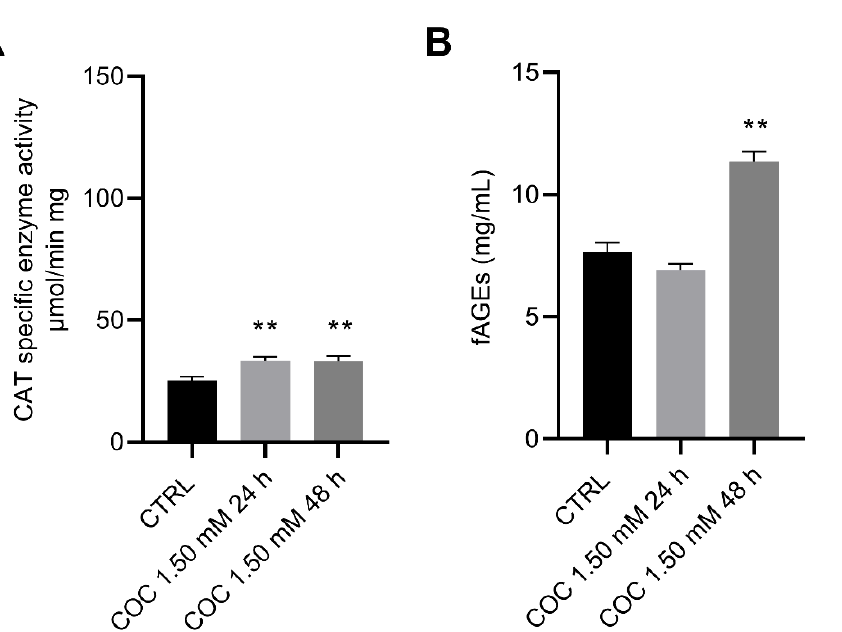
Figure 4. Oral feeding of cocaine leads to an increase in CAT activity and accumulation of fAGE. Male flies were fed either 1.50 mM cocaine (COC) for 24 or 48 h or left untreated, control (CTRL). Whole body homogenates were prepared at 09:00. ( A ) Catalase (CAT) specific enzyme activity. ( B ) Fluorescent advanced end glycation products (fAGEs) concentration determined using calibration curve for standard calibrator fAGEs-BSA (bovine serum albumin). All measurements were performed in triplicate (n = 9). **: p < 0.01 using one-way ANOVA with Tukey’s multiple comparison post-hoc test.